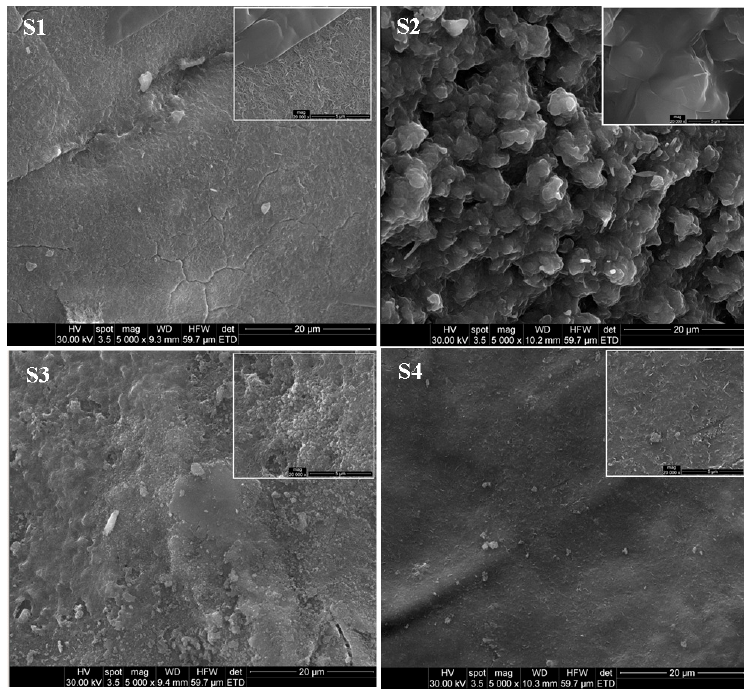
Figure 4. SEM images for LDHs, before (samples S1 and S2) and after (samples S3 and S4) Mn 2+ adsorption.